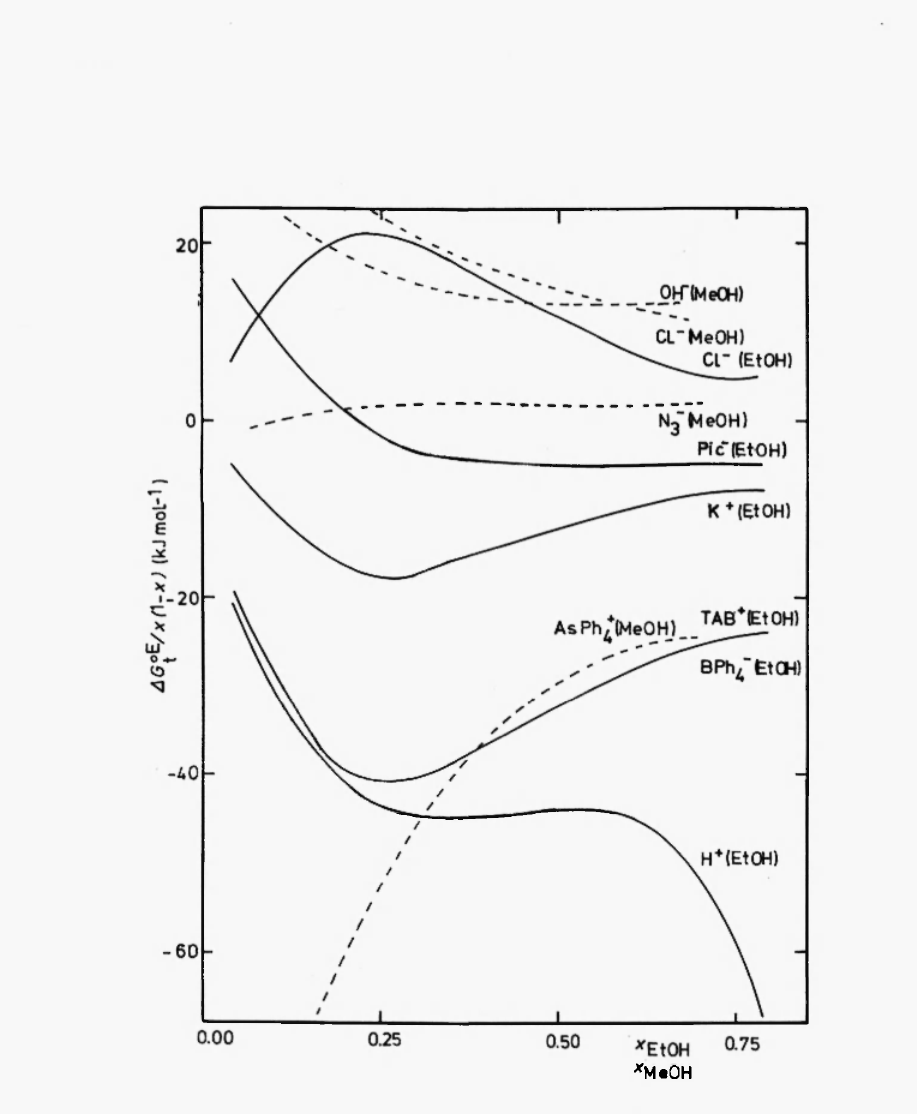
Fig. 1. Preferential interaction Gibbs free energies Ιχ(λ-χ), eq. (39), for transfer of the indicated ions from water to aqueous mixtures with the indicated alcohol, plotted against the mole fraction χ of the alcohol in the mixture (after ref.